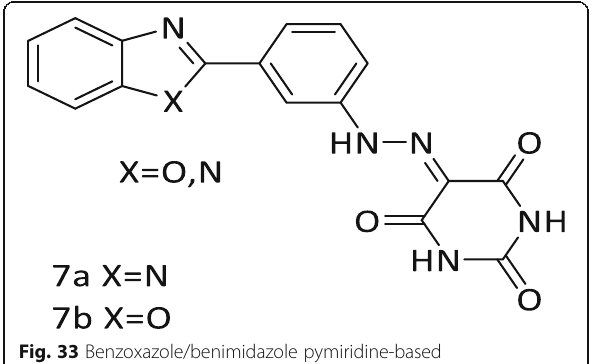
Fig. 33 Benzoxazole/benimidazole pymiridine-based hybrid compounds